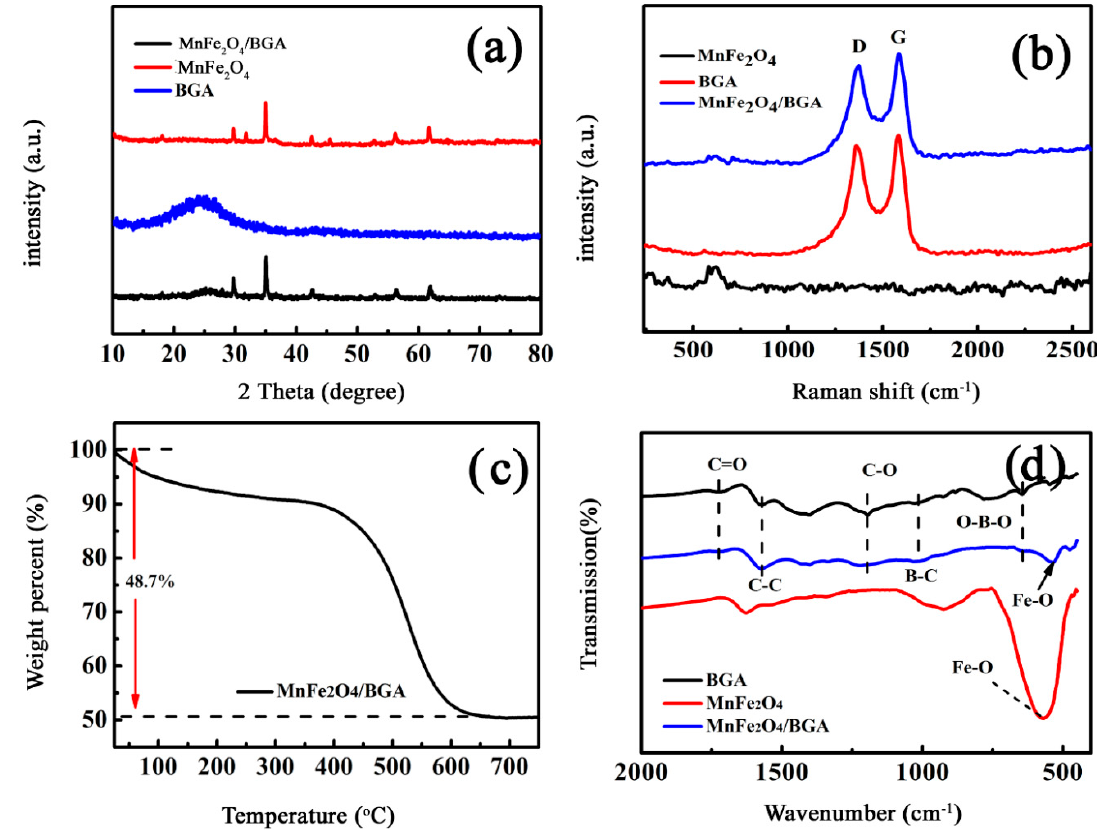
Figure 3. ( a ) XRD patterns, ( b ) Raman spectra, ( c ) TGA of the MnFe 2 O 4 /BGA composite (air flow at a heating rate of 10 °C/min), and ( d ) FT − IR spectra of BGA, MnFe 2 O 4 , and MnFe 2 O 4 /BGA.